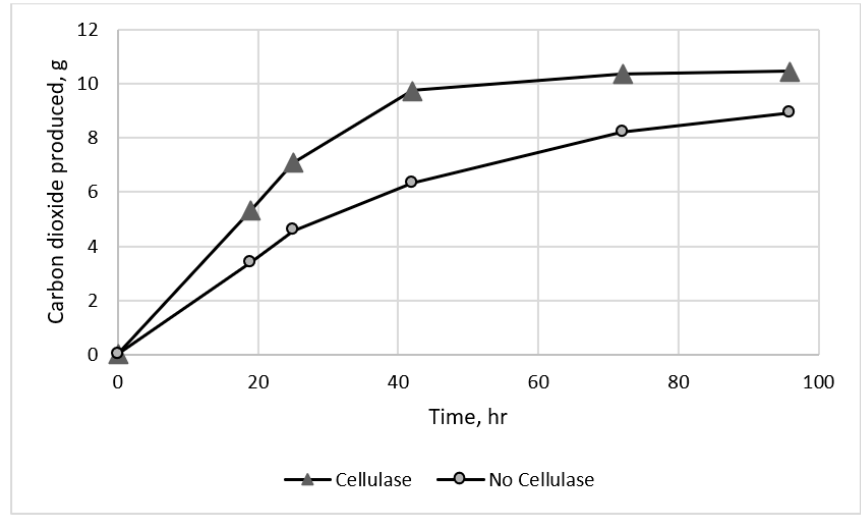
Figure 4. Mean CO 2 produced for treated sorghum with and without cellulase addition (n = mean 6).